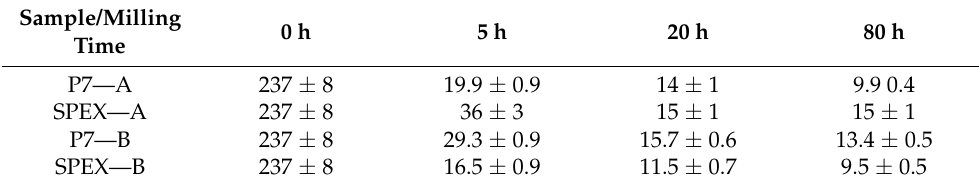
Table 2. Crystalline size, L (nm), of the cubic bcc Fe main phase.